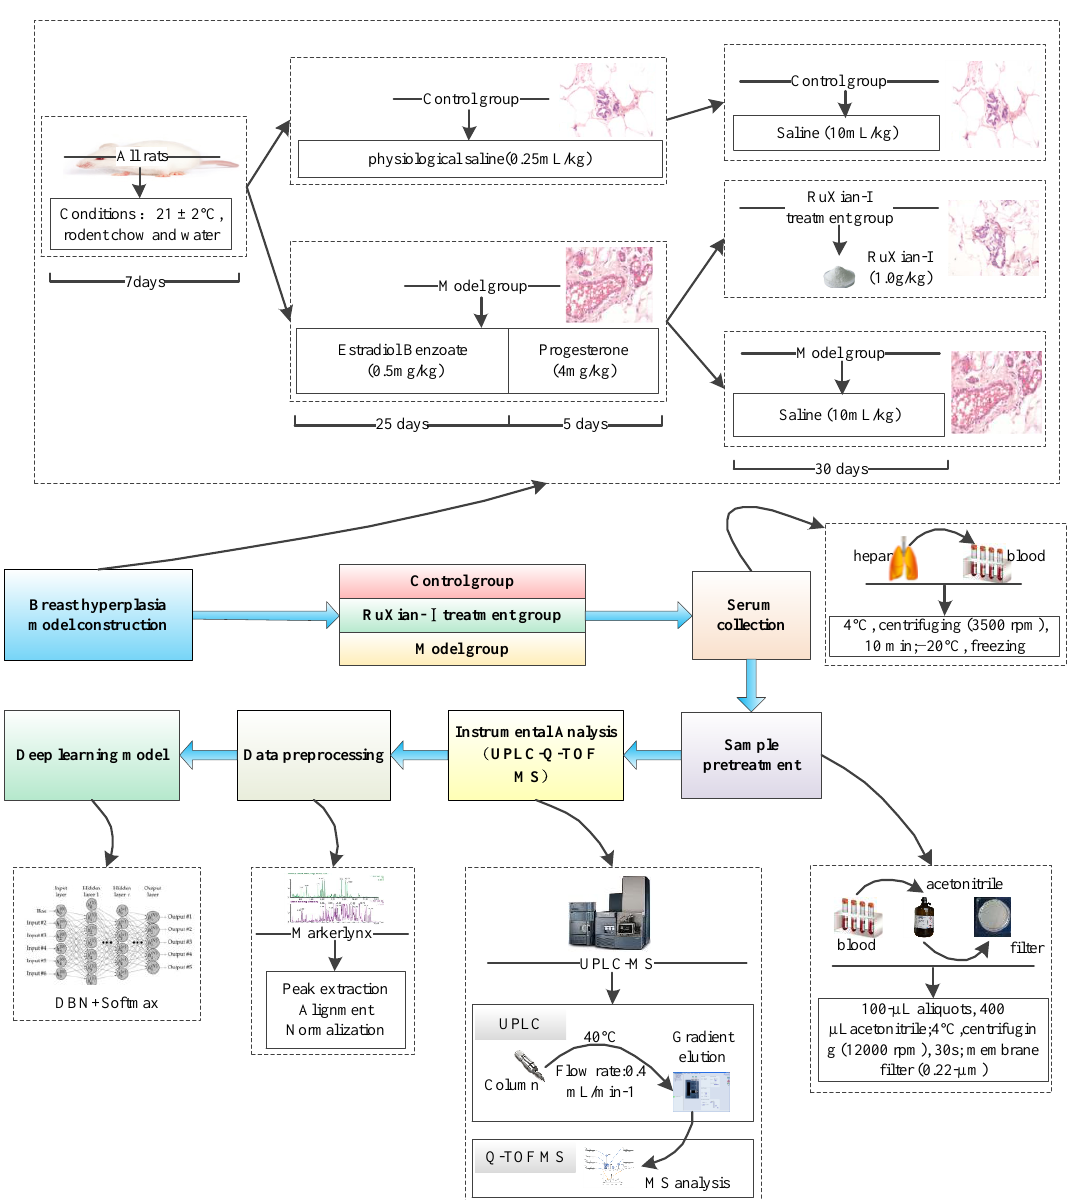
Figure 1. The framework of the metabolomics deep belief network (MDBN).